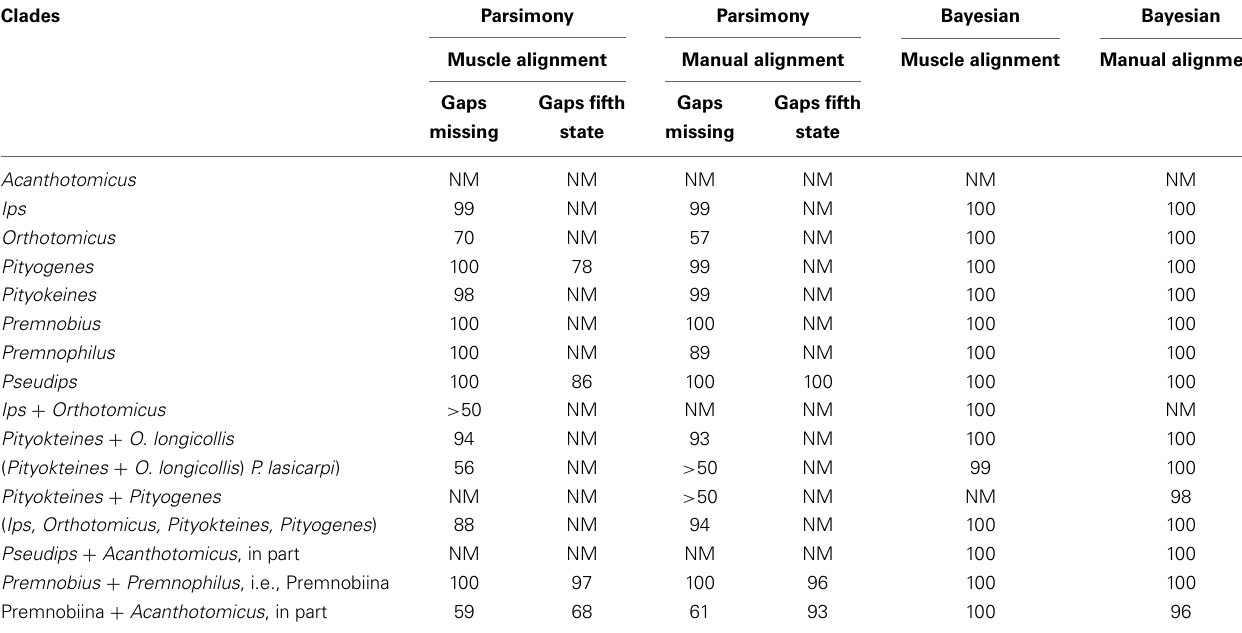
Table 3 | Summary of phylogenetic